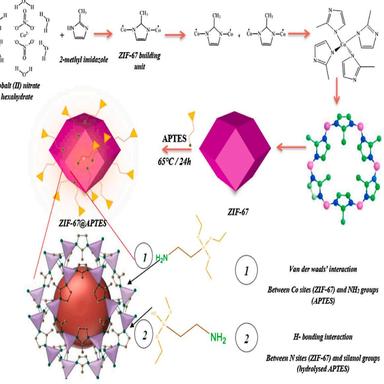
ZIF-67 fabrication process, structure, and its modification with (3-Aminopropyl) triethoxysilane.